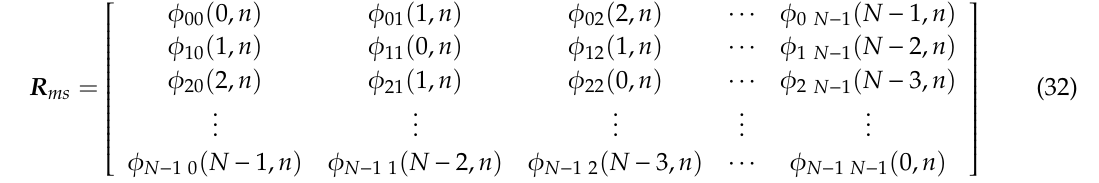
Figure 9. The power spectral density of the input signal x ( n ).